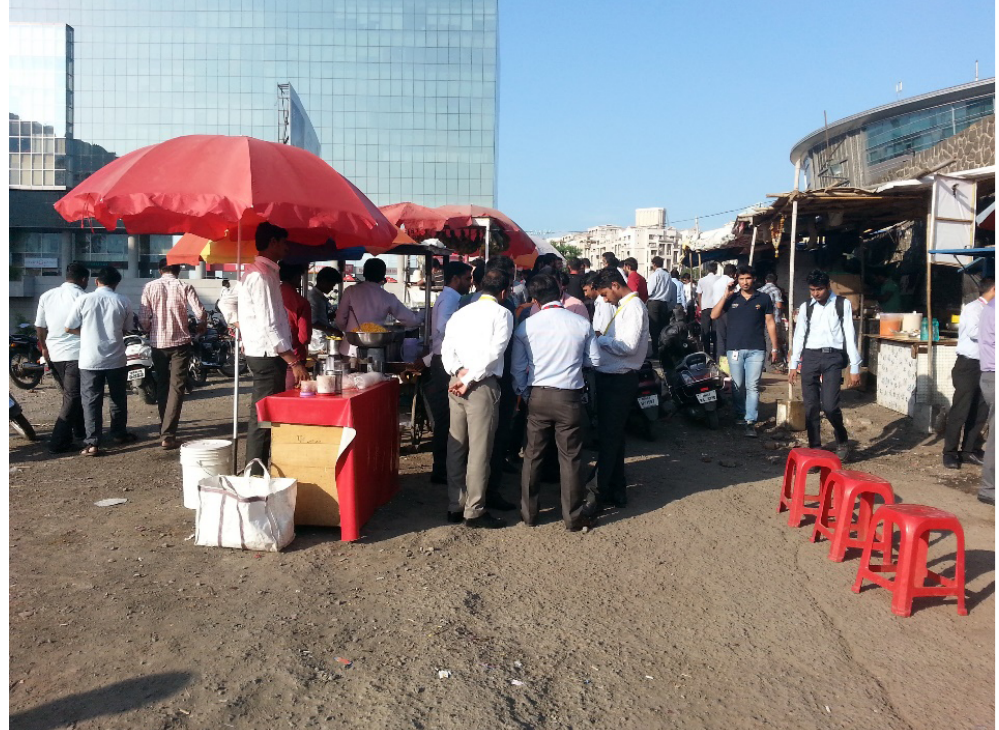
Figure 2. Makeshift food and tea stalls ( Tapri ) outside Eon IT Park in Kharadi. Source: